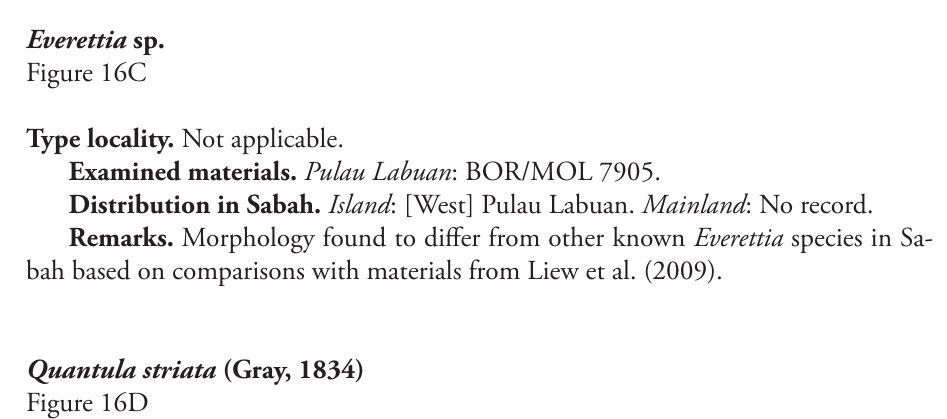
Type locality. Not